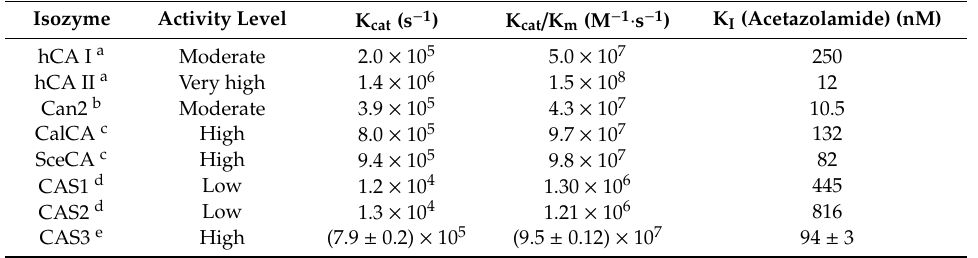
Can2 b Moderate 3.9 × 10